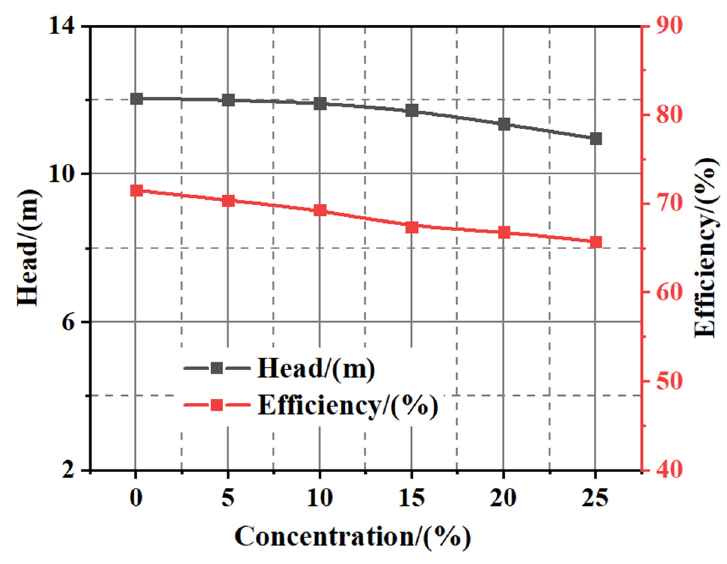
Figure 9. External characteristic curves of different concentrations.